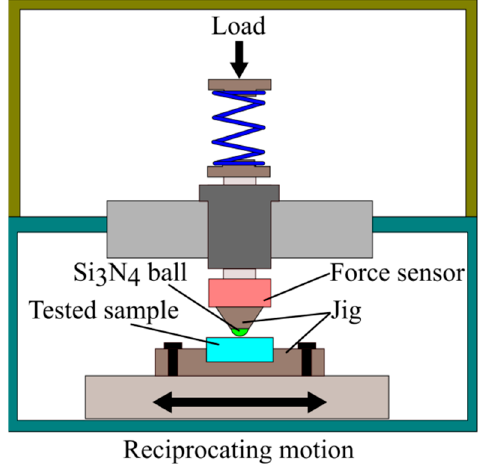
Figure 3. Principle diagram of sliding wear .